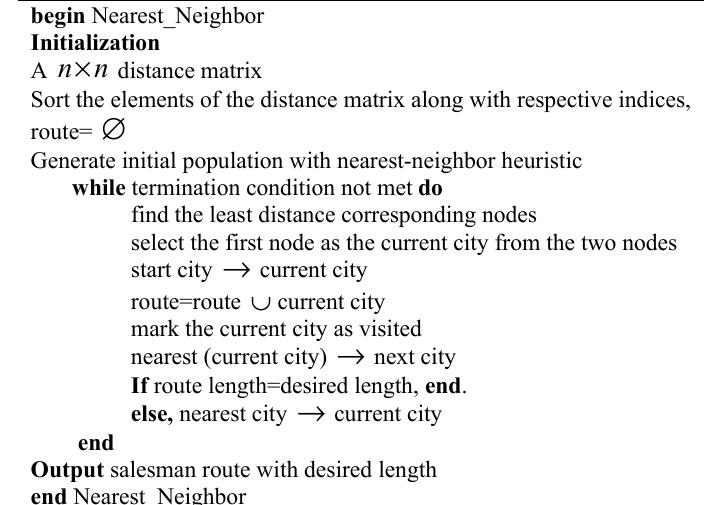
Algorithm 3.1. Nearest neighbor